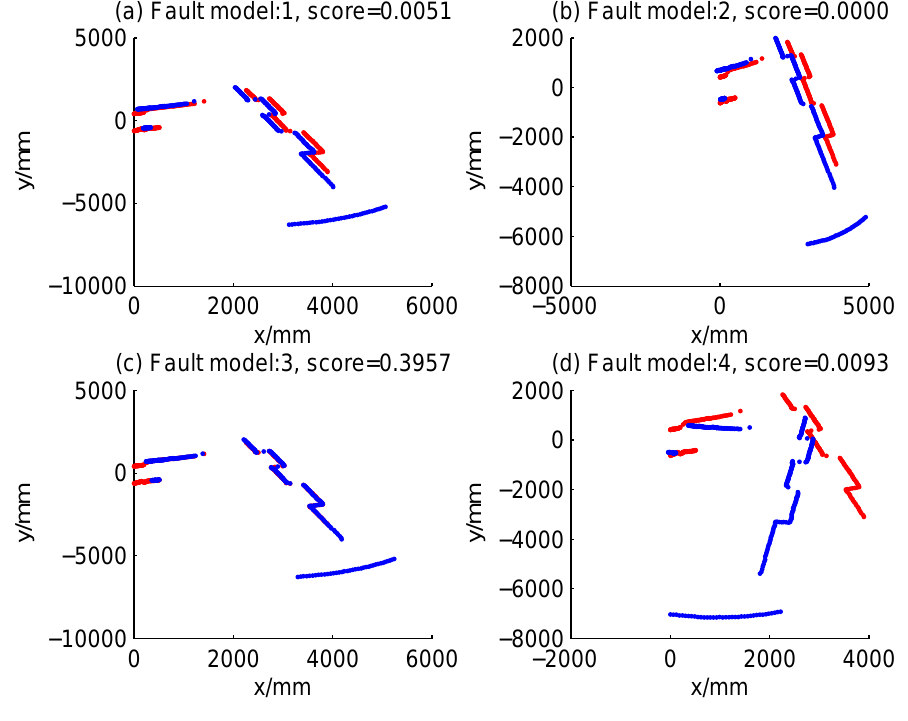
Figure 17. Case 3a: Right encoder stuck, fault model = 3 (time Step